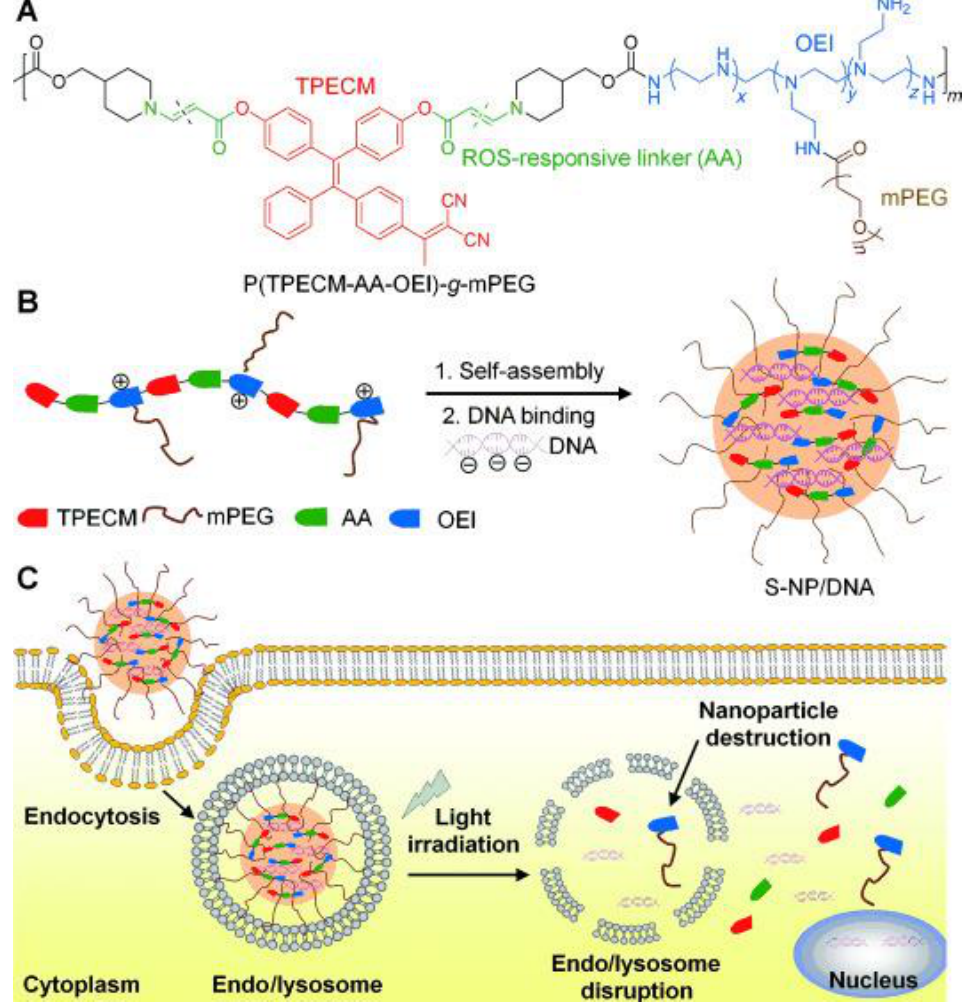
Figure 19. ( A ) Chemical structure of the ROS-responsive polymer P(TPECM-AA-OEI)-g-mPEG. ( B ) ROS-sensitive nanoparticles (S-NPs) self-assembled from P(TPECM-AA-OEI)-g-mPEG in aqueous media and their complexation with DNA to form S-NPs/DNA. ( C ) The itinerary of S-NPs/DNA to the transgene expression. S-NPs/DNA was endocytosed by the cells and entrapped in endo/lysosomes. Upon light irradiation, the generated ROS can concurrently destroy the endo/lysosomal membrane to facilitate the vector escape and break the S-NPs to favor DNA unpacking, leading to DNA release for nuclear entry and transcription. Reproduced with permission from reference [149]. Copyright 2015, John Wiley and Sons.